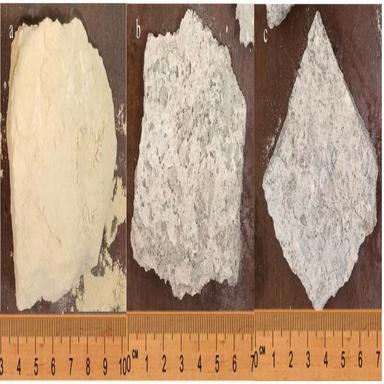
Representative Samples of Historical Wall: a) Stone; b) Mortar; c) Plaster.